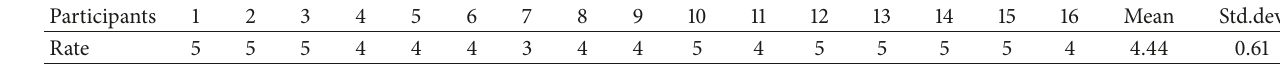
Table 2: LittleBigPlanet2 user experience ratings.